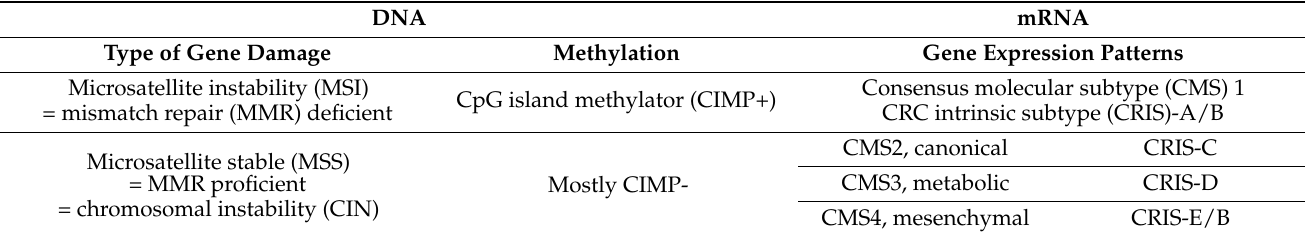
Table 1. Molecular phenotypes of colorectal cancer according to the prevalent patterns of